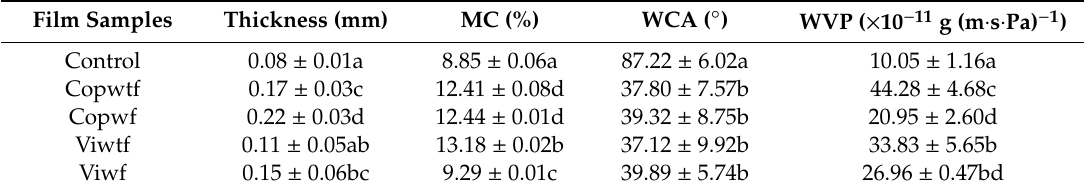
Table 2. Thickness, moisture content (MC), water contact angle (WCA) and water vapour permeability (WVP) of Copena F1 without fibre (Copwtf), Copena F1 with fibre (Copwf), Villanueva without fibre (Viwtf) and Villanueva with fibre (Viwf)